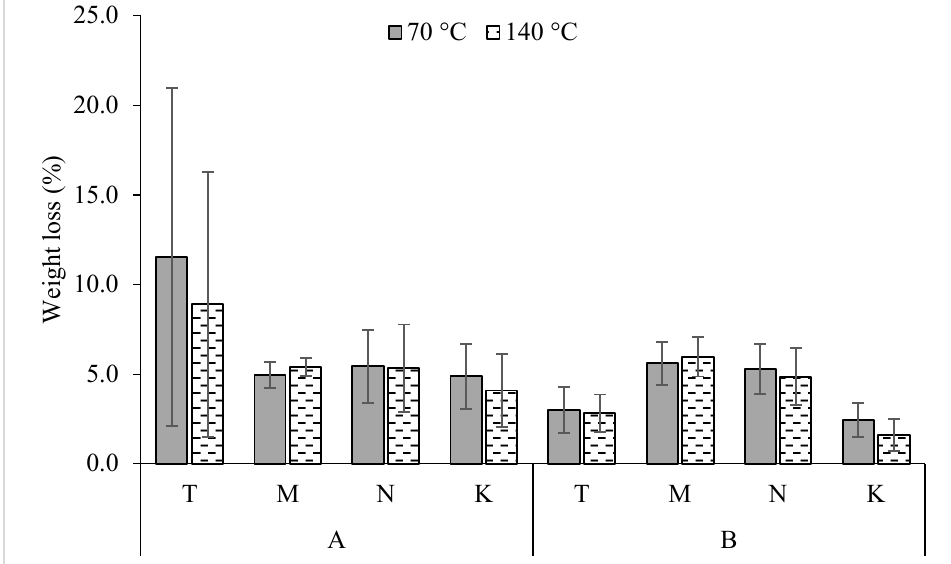
Figure 4. Weight loss of manii wood in the subterranean termite test after heating at 70 or 140 °C and treatments with boric acid (B), without boric acid (A), with neem oil (M), with tamanu oil (N), with candlenut oil (K), and without oil (T).